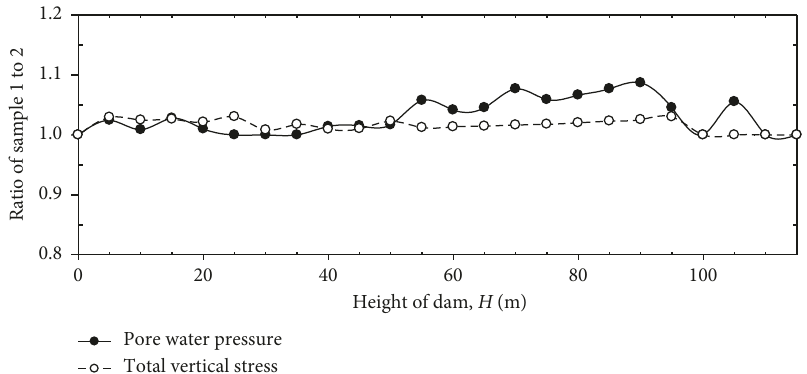
Figure 4: Pore water pressure ratio and total vertical stress ratio of the first sample to those of the second sample.